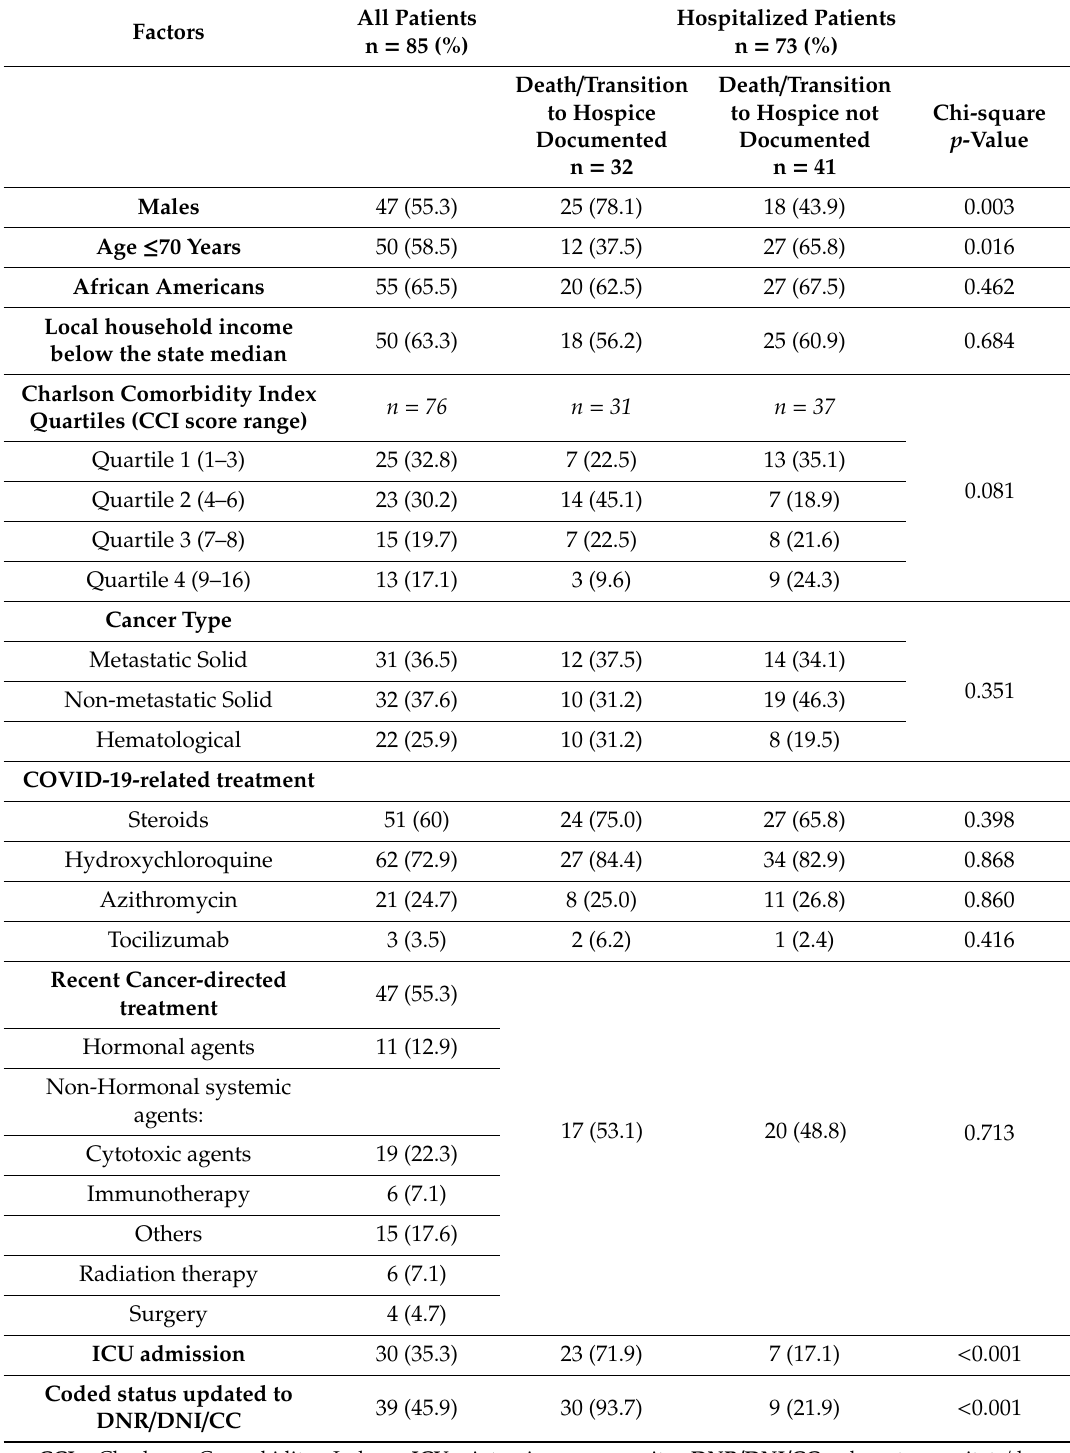
Table 1. Baseline